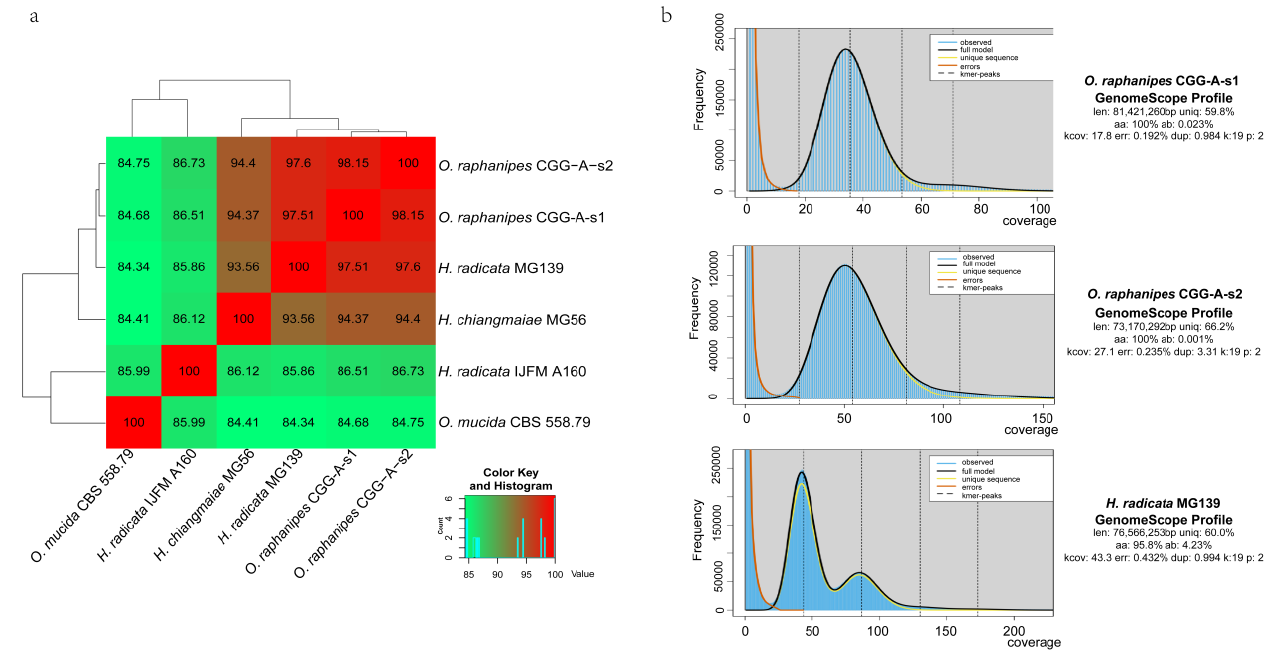
Figure 4. Genome assembly comparison within O. raphanipes and closely related strains. ( a ) Cluster heatmap of ANI values between six strains. ( b ) Histogram of the 19-mer depth distribution of the Illumina sequencing reads of O. raphanipes CGG-A-s1 and H. radicata MG139 plotted by GenomeScope. Blue areas indicate the observed k-mer frequencies and the black line indicates the fitted GenomeScope model.